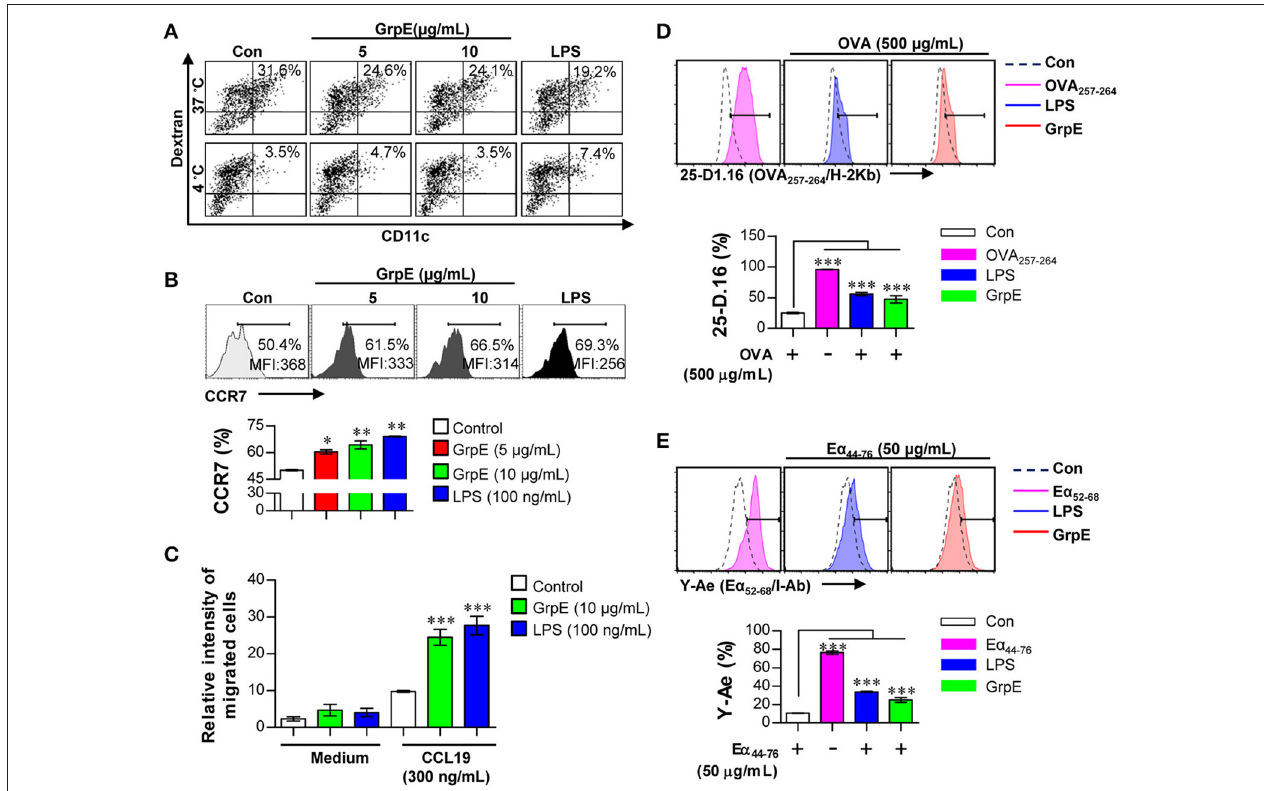
FIGURE 2 | Ag uptake, migration, and Ag presentation capability of DCs by GrpE treatment. (A–C) DCs were treated with GrpE or LPS for 24h. (A) Cells were incubated with dextran-FITC at 37 and 4 ◦ C for 30min, and assessed by flow cytometry. The percentages of dextran + CD11c + cells are indicated. One representative plot from three independent experiments is shown. (B) CCR7 expression in DCs (on gated CD11c + ) was analyzed by flow cytometry. (C) DCs were treated with GrpE and the relative intensity of migrated cells was identified through CCL19. Bar graphs display mean ± SD ( n = 3 samples) and statistical significance (* p < 0.05, ** p < 0.01, or *** p < 0.001) is shown for treatments compared to non-treated DCs (Control). (D , E) DCs were treated with LPS or GrpE, and then pulsed with OVA protein or E α 44 – 76 peptide. After 24h, cells were stained with anti-CD11c, anti-25-D1.16, or anti-Y-Ae mAbs. Histogram and bar graphs for expression of OVA 257 – 264 /H-2Kb (D) and E α 52 – 68 /I-Ab complexes (E) are displayed. OVA 257 – 264 or E α 52 – 68 peptide (each peptide; 2 µ g/mL concentration) was used as a positive control for antigen presentation. Histogram data are representative result of three experiments. Bar graph data is expressed as the mean ± SD ( n = 3 samples); *** p < 0.001; Con denotes untreated